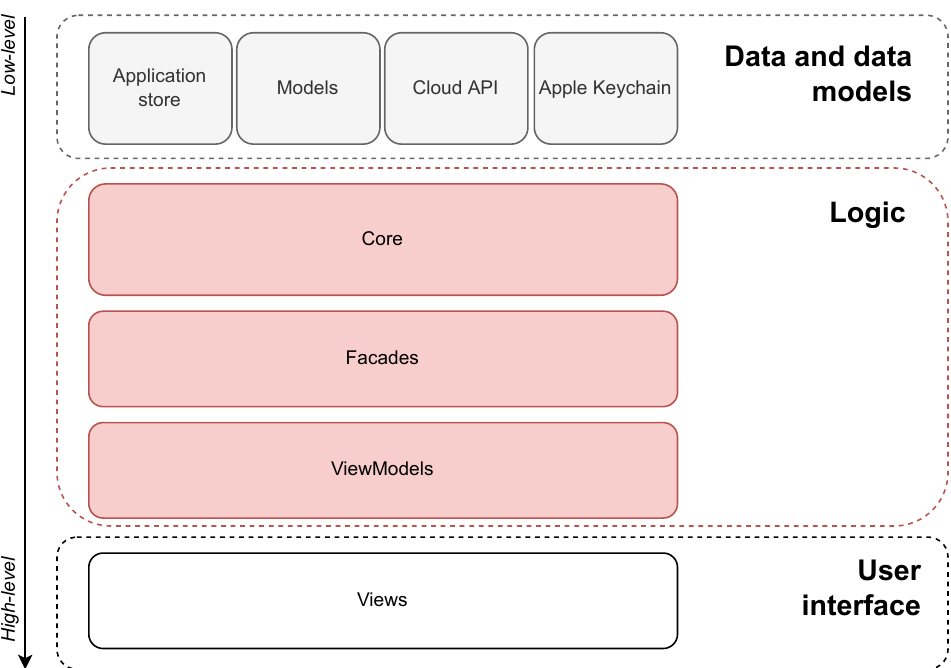
Figure 2. Hierarchy of components of the software architecture of